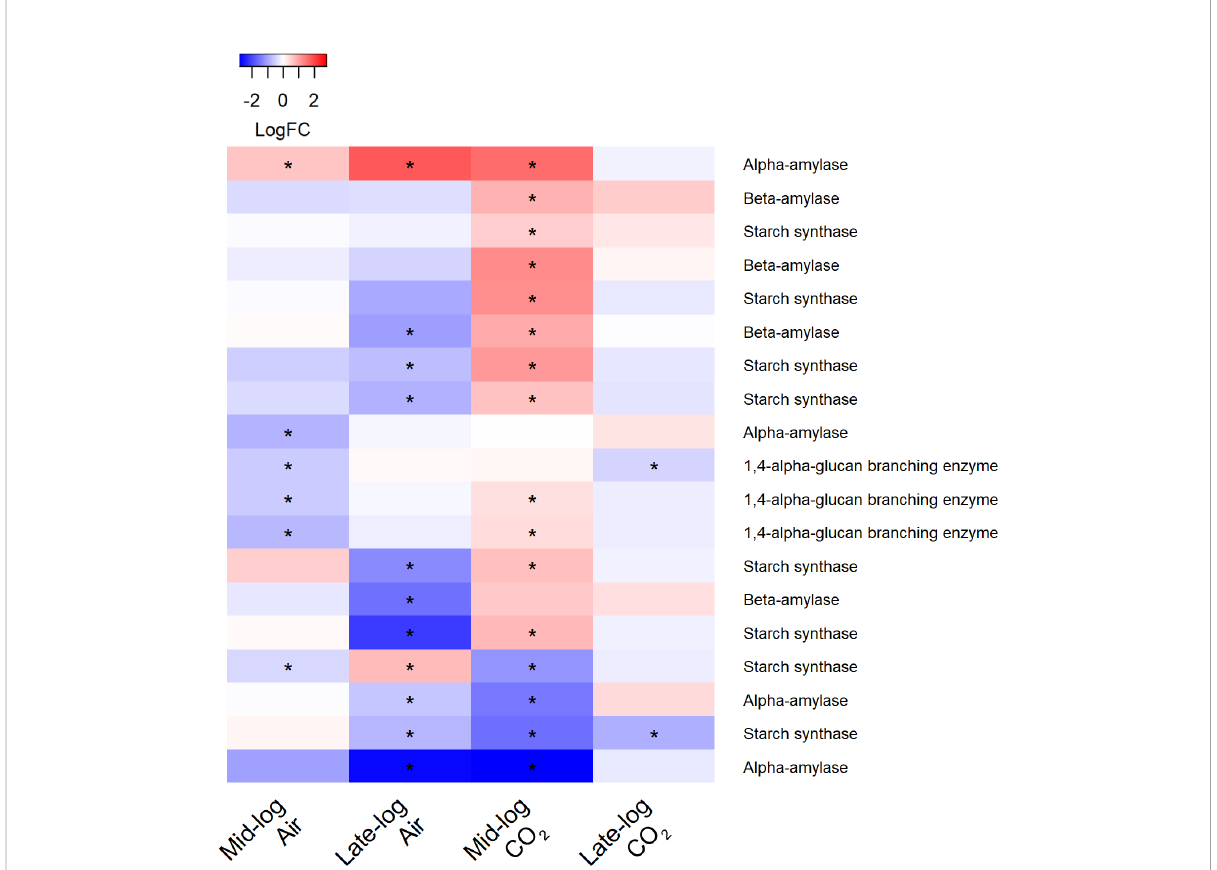
FIGURE 9 Heat map of differentially expressed transcripts involved in starch metabolism in S. obliquus grown in the presence of switchgrass in ambient (i.e., air) and 1% CO 2 during mid- and late-log phase growth. Differential expression is presented from a mean of triplicate samples as the log fold change of transcripts from cultures containing switchgrass compared to cultures of the algae alone. Stars indicate an adjusted p-value of less than